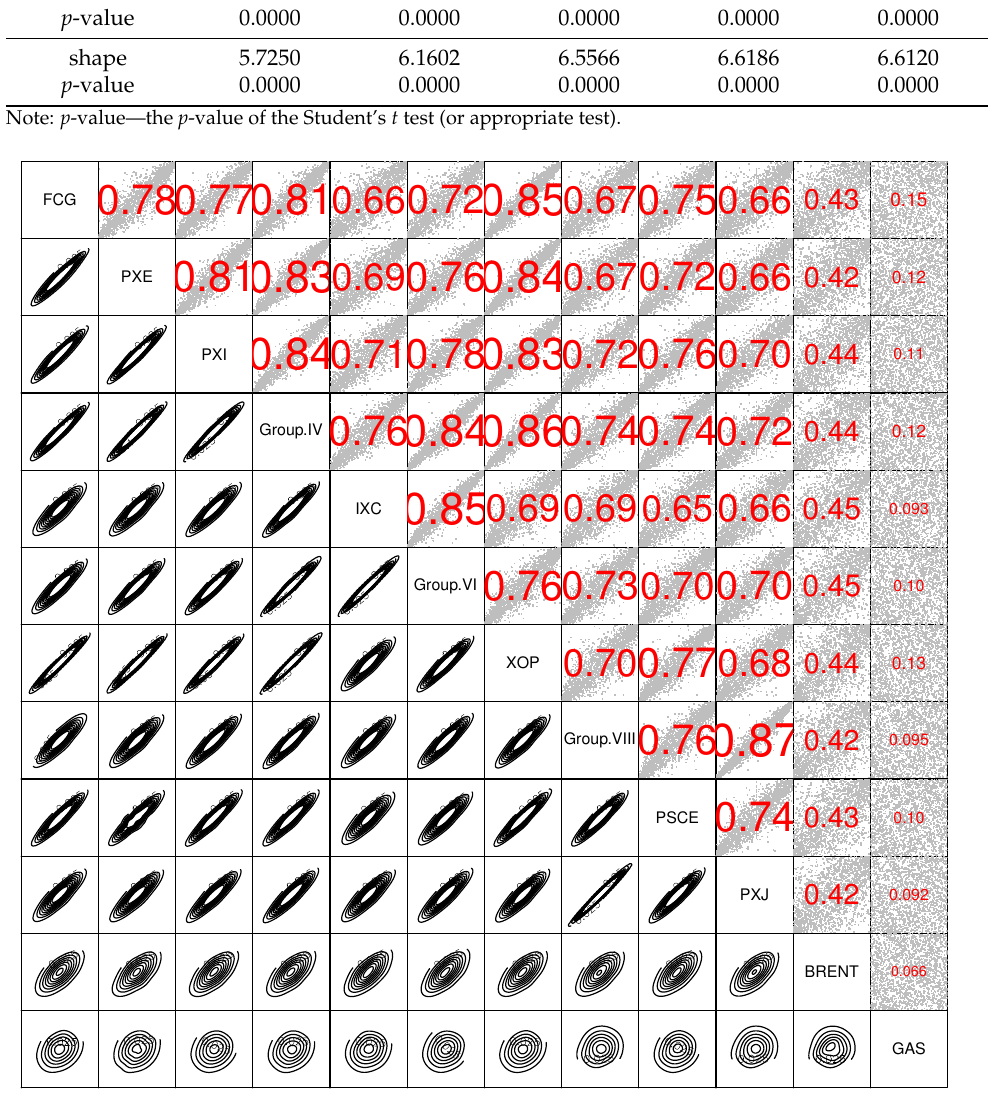
Figure A7. Kendall’s τ and copulas for oil, gas, and